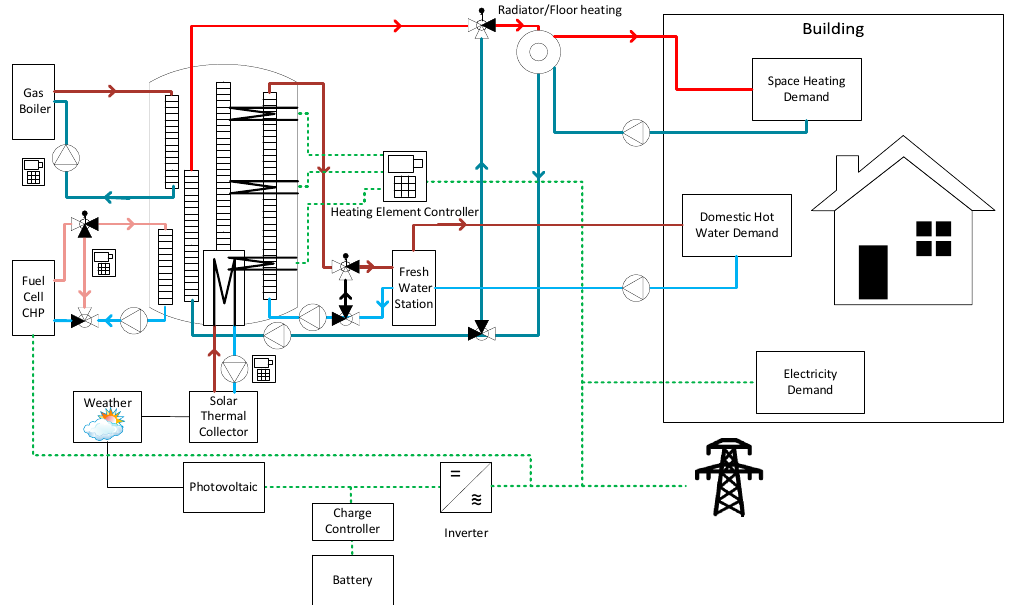
Figure 3. Schematics of the energy system as simulated in TRNSYS.